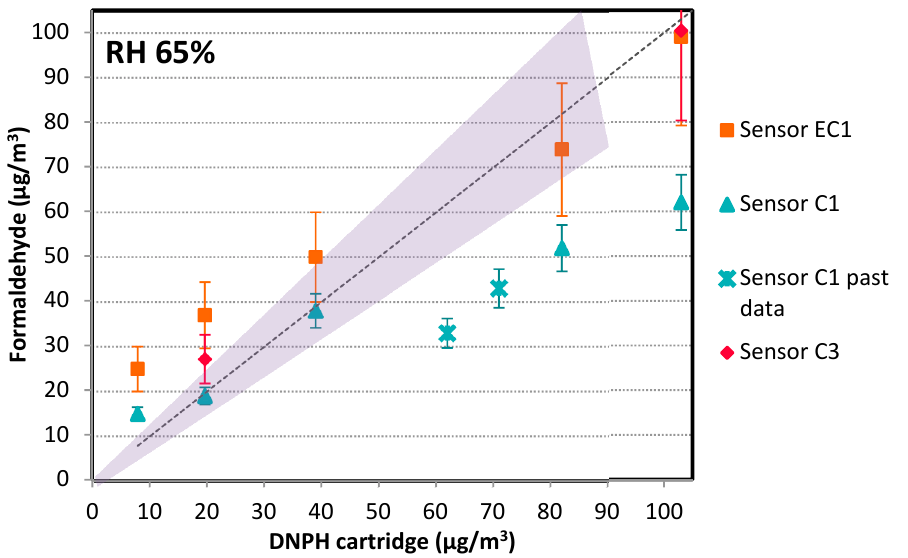
Figure 9. Comparison of HCHO concentration from sensors versus reference method at 23 °C and 65% RH.